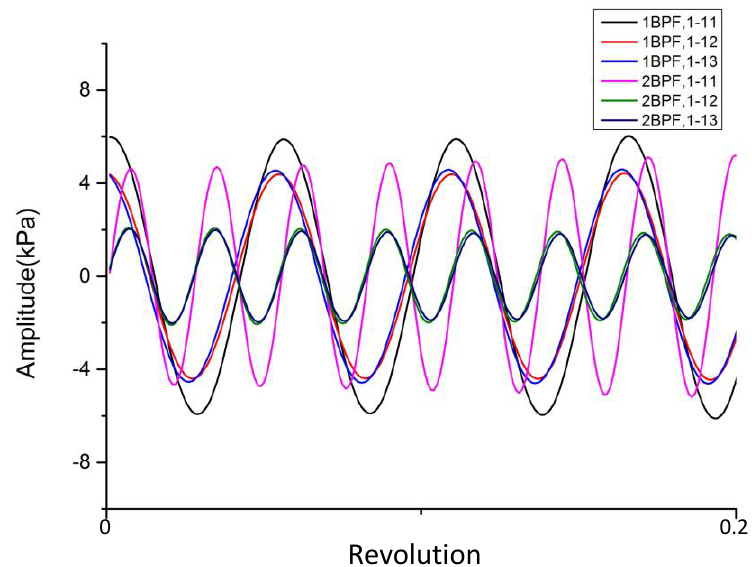
Figure 12 . The pressure fluctuation of the blade sweep at the rear part of the R1 passage . Figure 12. The pressure fluctuation of the blade sweep at the rear part of the R1